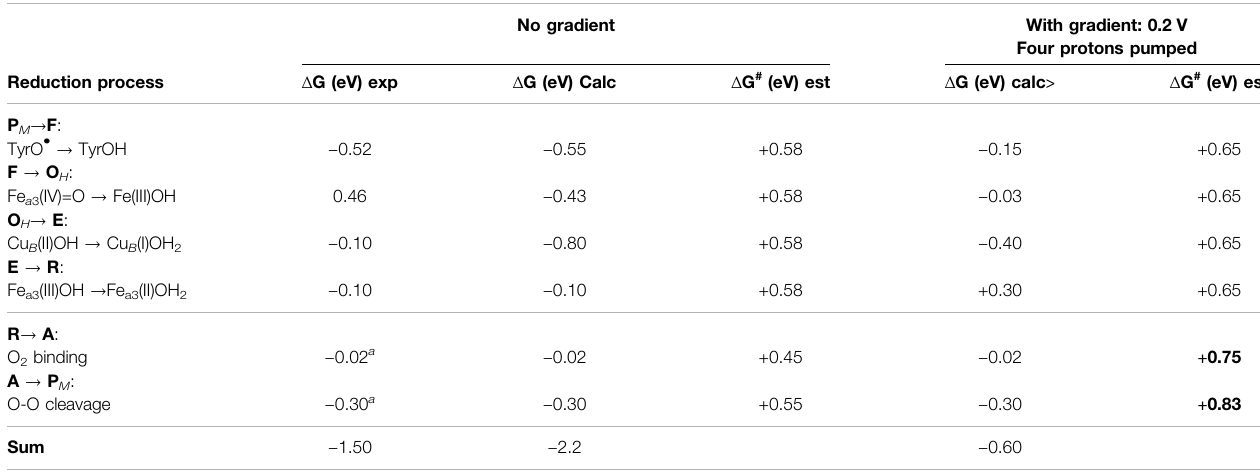
TABLE 1| Driving forces, Δ G(eV), forthe individual reduction stepsin thecatalytic cycle, asobtained from experiments (Kaila et al.,2010) and from the present calculations. Note that the fi rst column shows only the cofactor reduced in each particular step, not the full BNC. Rate-limiting barriers, Δ G # (eV), estimated from experimental information are also given for each step. The effects on the driving forces and the barrier heights of the presence of the electrochemical gradient across the membrane are also